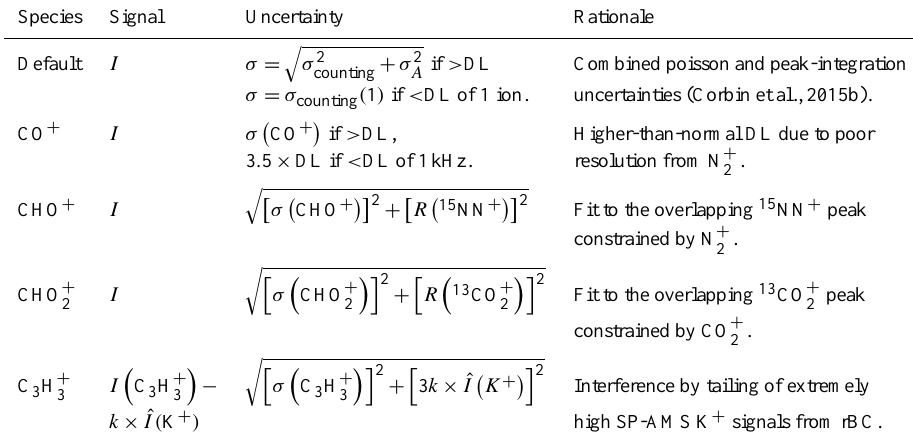
Table 1. AMS and SP-AMS uncertainties σ used in this study and their detection limits (DLs). I (cid:0) X + (cid:1) is the rate of counts of ion X + ; ˆ I (cid:0) X + (cid:1) is I (cid:0) X + (cid:1) normalized to its maximum value; R (cid:0) X + (cid:1) is the abundance of an ion X + relative to its most abundant isotopologue; and k is a constant determined as 1µgm − 3 as discussed in the